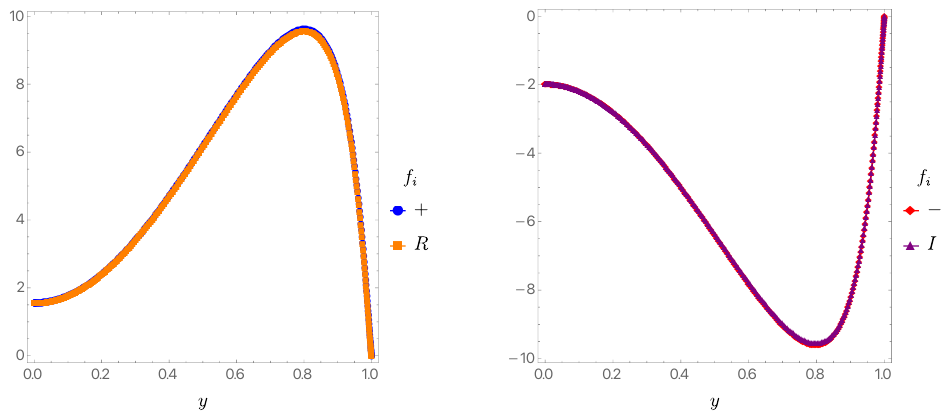
Figure 4 . Left panel : two eigenfunctions are plotted as a function of y . The blue disks rep- resent f + , defined as the limit of the positive-norm eigenfunction from region I , and the orange squares represent f R , defined as the limit of the real part of the complex eigenfunction (using our normalisation) from region II . Right panel : two eigenfunctions are plotted as a function of y . The red diamonds represent f − , defined as the limit of the negative-norm eigenfunction from region I , and the purple triangles represent f I , defined as the limit of the imaginary part of the complex eigenfunction (using our normalisation) from region II . Region I is defined as y 0 . y b = 6 . 0285 , while region II is defined as y 0 & y b